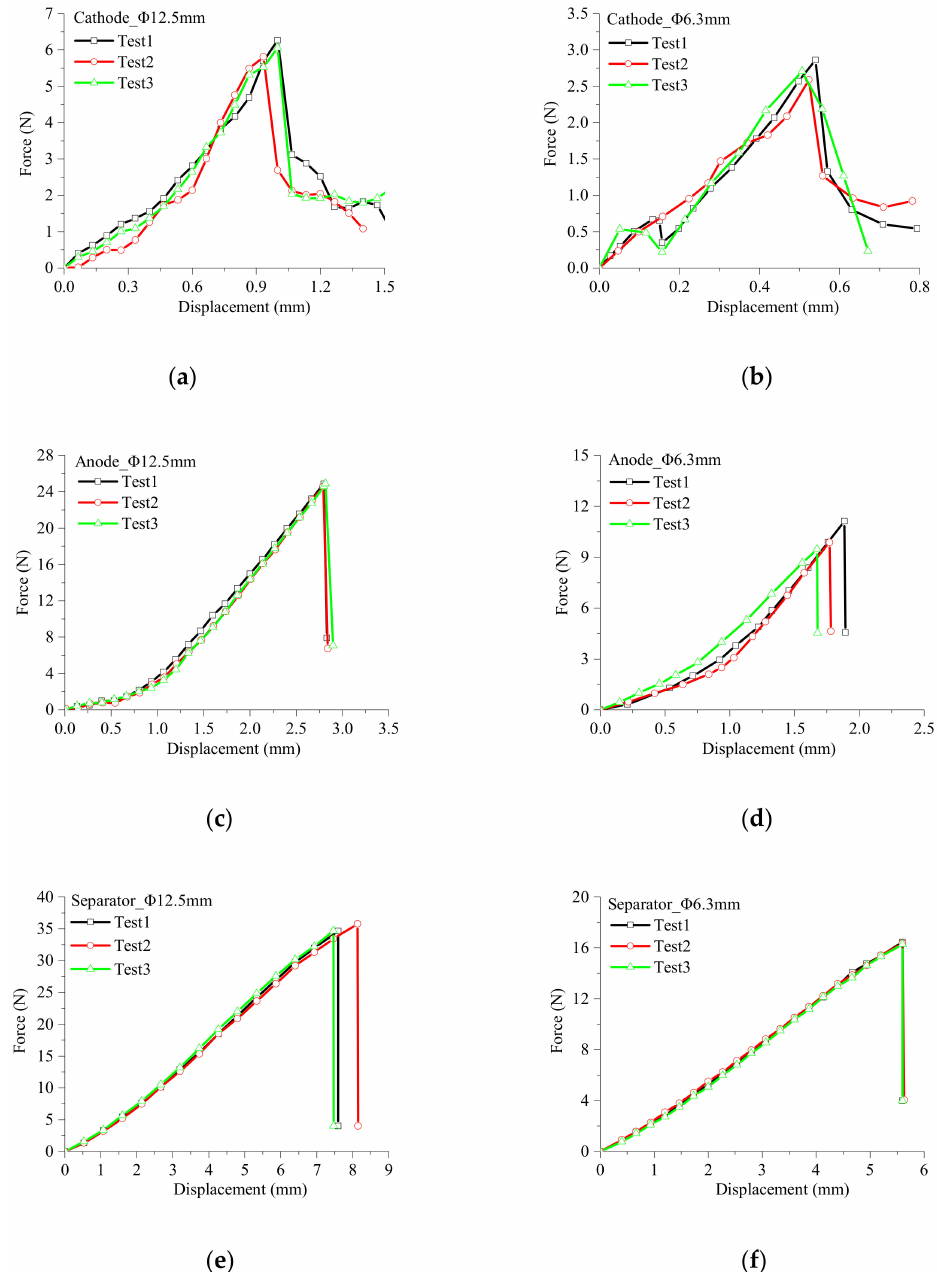
Figure 5. Force-displacement curves of lithium-ion prismatic cell components under different sizes of spherical punches: ( a ) Cthode tests under Φ 12.5 mm; ( b ) Cthode tests under Φ 6.3 mm; ( c ) Anode tests under Φ 12.5 mm; ( d ) Anode tests under Φ 6.3 mm; ( e ) Separator tests under Φ 12.5 mm; ( f ) Separator tests under Φ 6.3